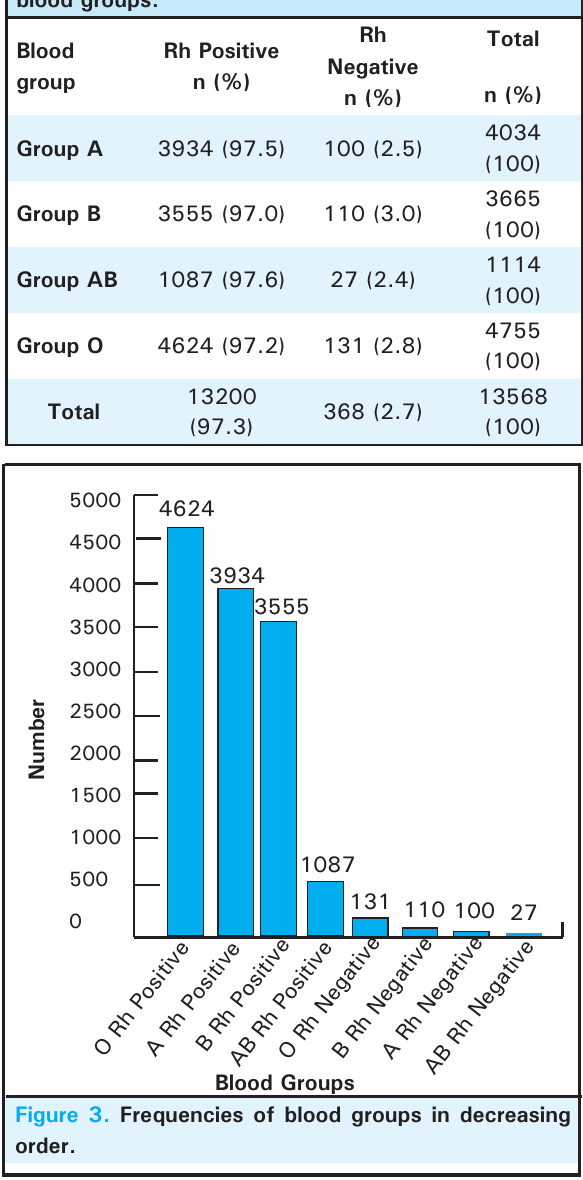
Table 2. Distribution of Rh blood groups within ABO blood groups.